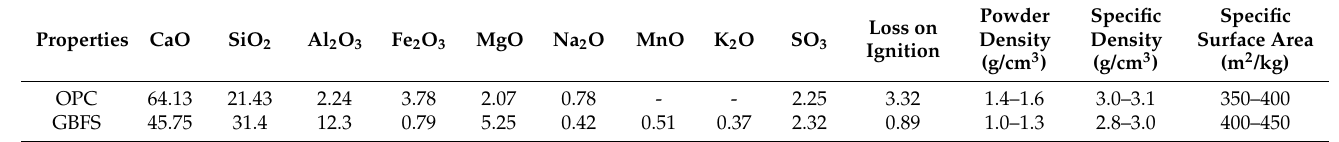
Table 1. Chemical properties (wt.%) and physical properties of the experiment materials.